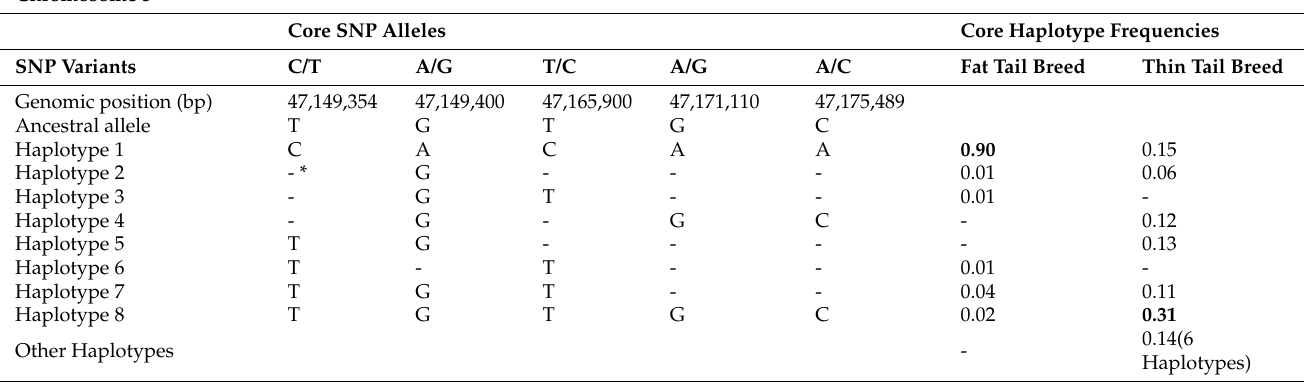
Table 3. Core SNP alleles and haplotype frequencies in candidate regions for fat tail (Lori) and thin tail (Zel) breeds: The haplotypes with higher frequency in fat and thin tailed breeds have been high- lighted.